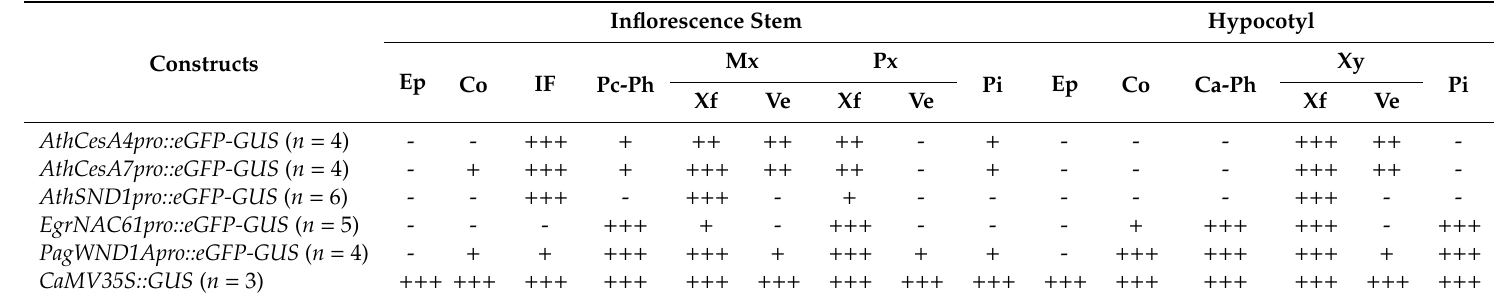
Table 1. Summary of GUS reporter staining in transgenic Arabidopsis